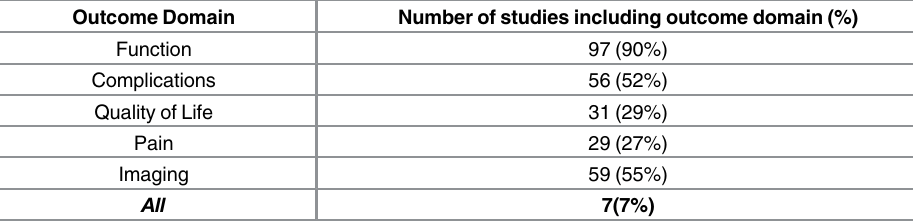
Table 1. Outcome domains identified by this systematic review.